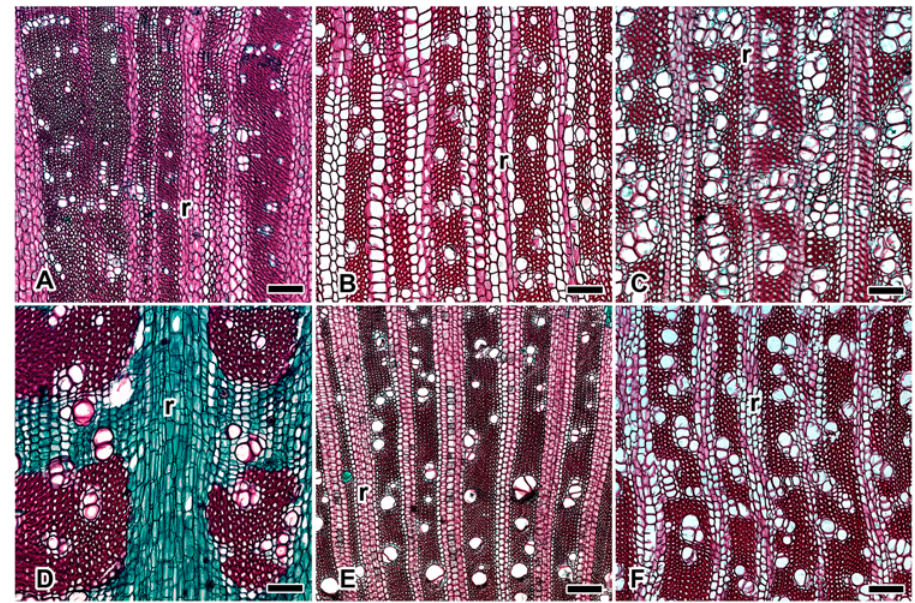
Fig 3. Fibrous wood in species of Cactaceae, cross sections, near the vascular cambium. Vessels embedded in a matrix of fibers with lignified rays except Opuntia streptacantha . (A) Cylindropuntia imbricata ; (B) Lophocereus marginatus ; (C) Myrtillocactus geometrizans ; (D) Opuntia streptacantha : wood with vessels embedded in a matrix of fiber or parenchyma with intermixed WBTs and non lignified rays; (E) Pereskia lychnidiflora ; (F) Stenocereus dumortieri . Bar is 200 μ m; r = ray.